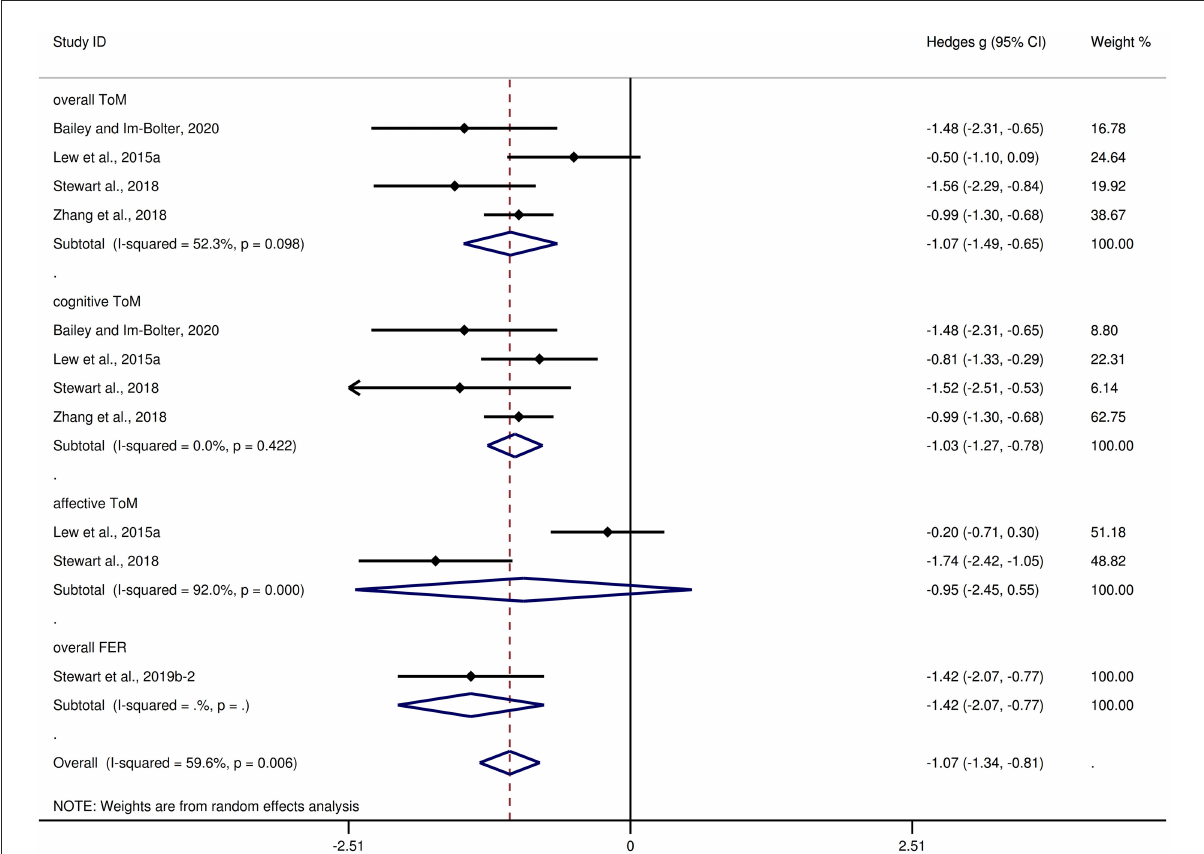
FIGURE5 Forest plots showing effect size estimates for overall ToM, cognitive ToM, affective ToM, and overall FER differences between generalized epilepsy and healthy